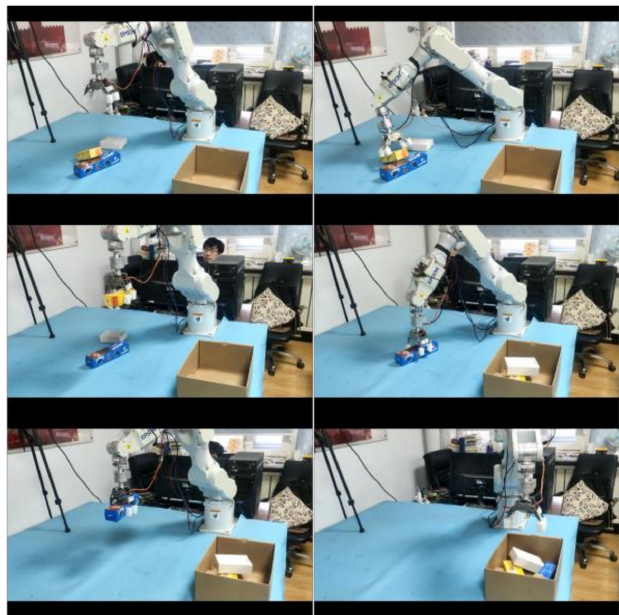
Figure 20. Multi-object sorting process.